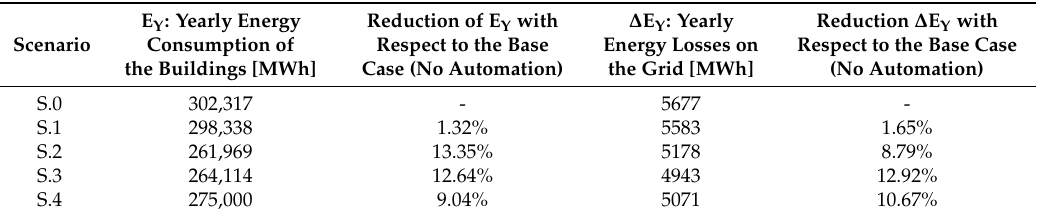
Table 8. Palermo–Energy consumptions and losses for the different control logics (No PV).